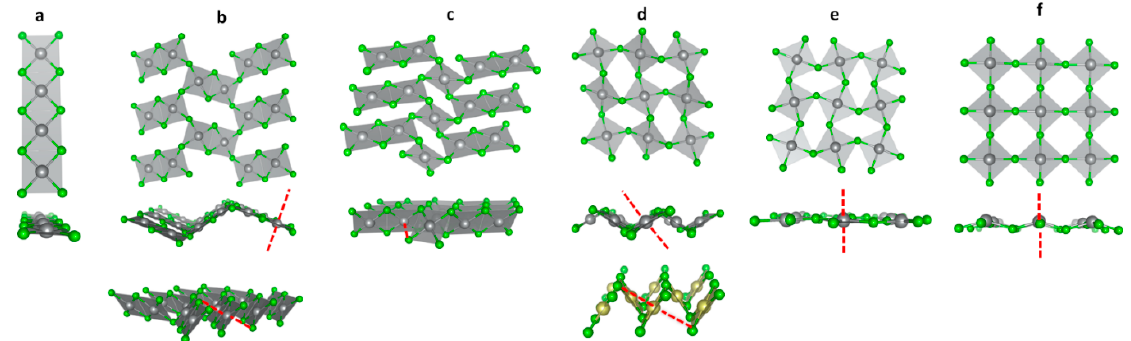
Figure 1. Illustration of main structural motifs that differ in connectivity of coordination polyhedra (the [AgCl 4 ] plaquettes) for the dynamically stable polymorphs of a hypothetical AgCl 2 compound predicted using the method of following imaginary phonon modes. Top and side view is shown. In the side views, the axial Ag-Cl contacts that complete the octahedral coordination of silver atoms are indicated by red dotted line. In panel b , two side views represent two distinct polymorphs, respectively. The lower side view in panel d (bottom), represents highly puckered layer that is observed in some transition metal dihalides, but not in AgCl 2 (see text for further explanation). Color code: Ag—big grey balls, Cl—small green balls, Pd—big yellow balls.